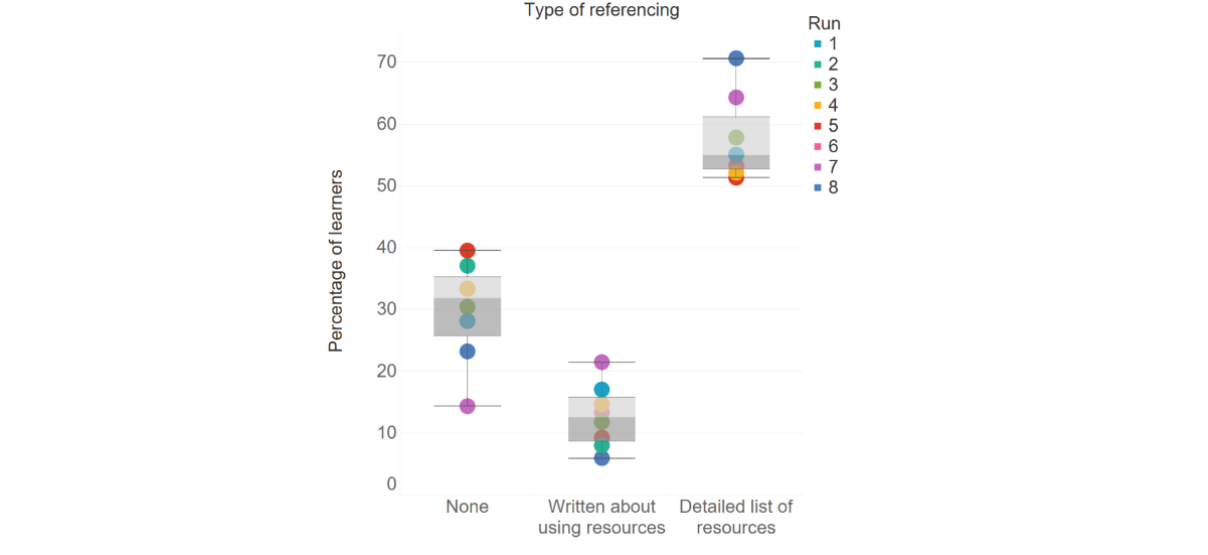
Figure 1. Analysis of the type of referencing in learner summary assignments.